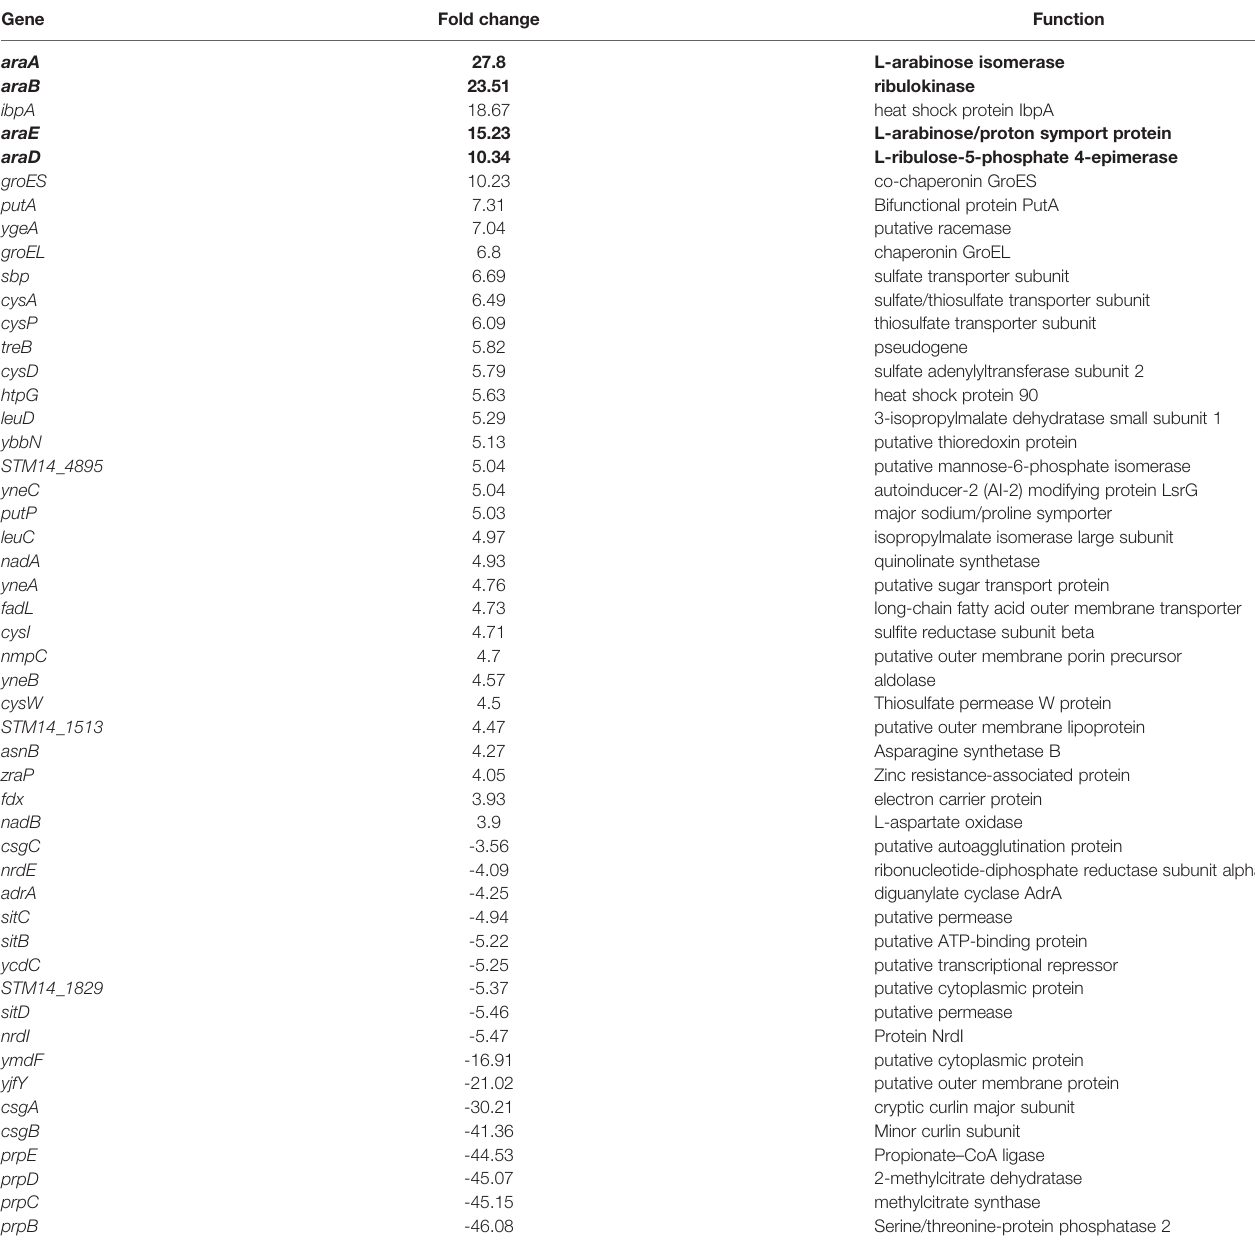
TABLE 2 | Top differentially regulated genes in WT bio fi lms grown in 40 mM L-Arabinose compared to 5 mM by RNA-Seq a . Gene Fold change